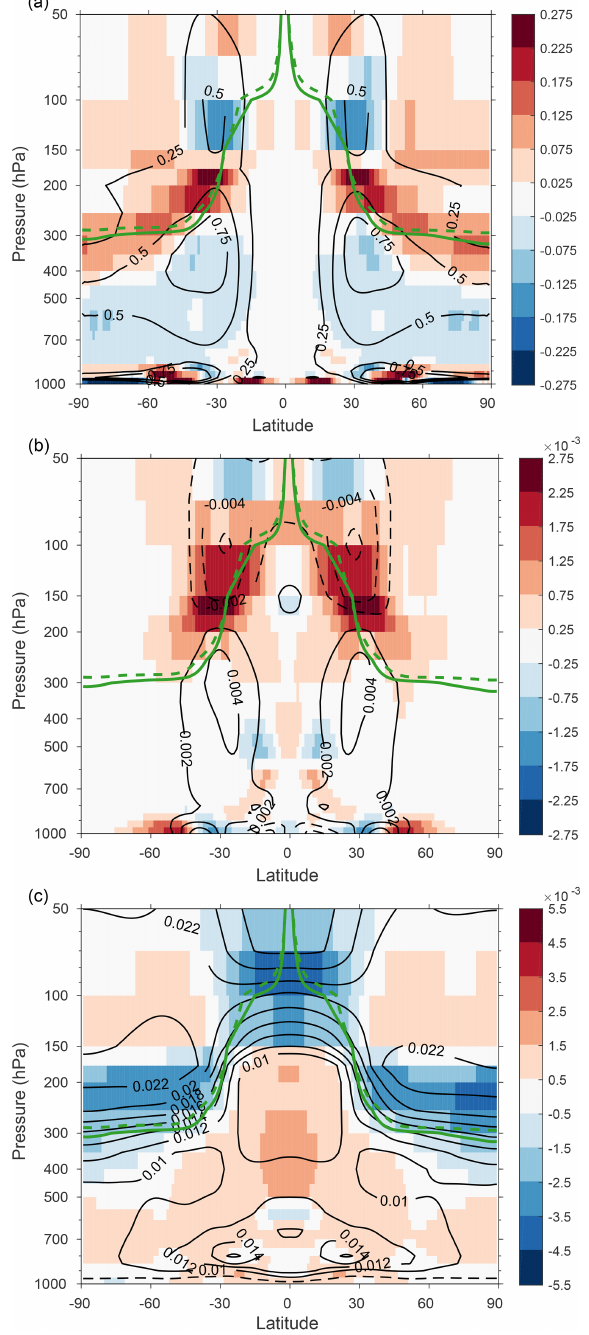
Figure 3. Zonal mean (a) maximum Eady growth rate (d − 1 ), (b) vertical shear of the zonal wind (s − 1 ), and (c) Brunt–Väisälä frequency (s − 1 ) averaged over 10 years of simulation. Black con- tours show the CNTL simulation, and shading shows the difference between the SST4 and control simulations (SST4 − CNTL). In (c) contours are every 0.002s − 1 for values greater than 0.01s − 1 , and the dashed line shows the 0.005s − 1 contour. The green solid line shows the dynamic tropopause (the 2PVU surface) in CNTL and the green dashed line in